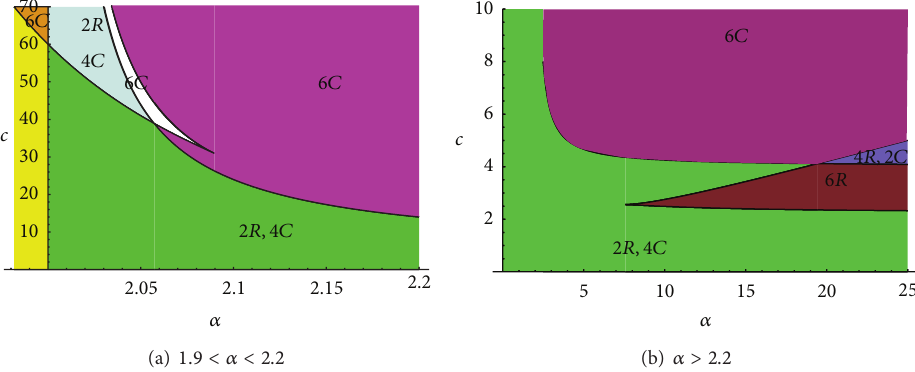
Figure 7: Critical points in the (𝛼,𝑐) -plane for 1.9 < 𝛼 and 𝑐 > 0